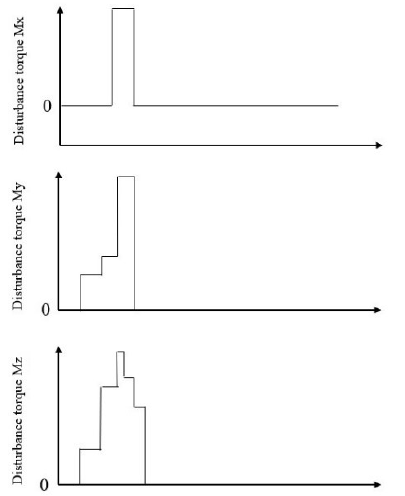
Figure 6. Schematic diagram of interference load in fairing separation.